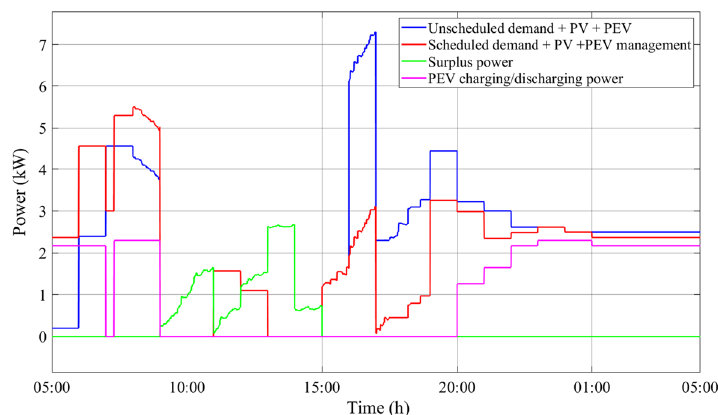
Fig. 19 Power profile